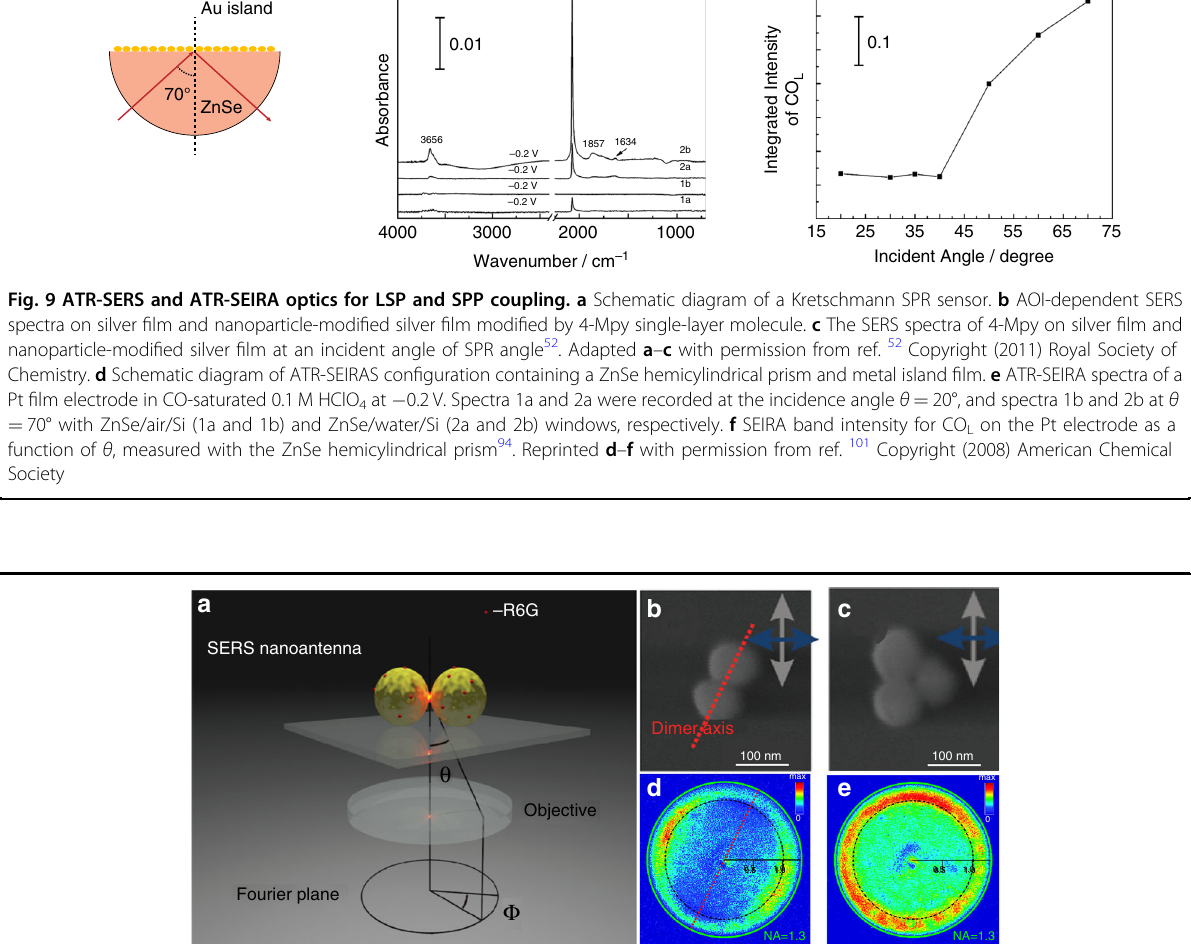
Fig. 10 Angle-resolved SERS optics for NP aggregations. a Scheme of the angle-resolved SERS detection. b SEM image of the dimer antenna. c SEM image of the trimer antenna. d SERS Fourier image of gold dimer nanoantenna. e SERS Fourier image of gold trimer nanoantenna 91 . Reprinted with permission from ref. 91 . Copyright (2011) American Chemical